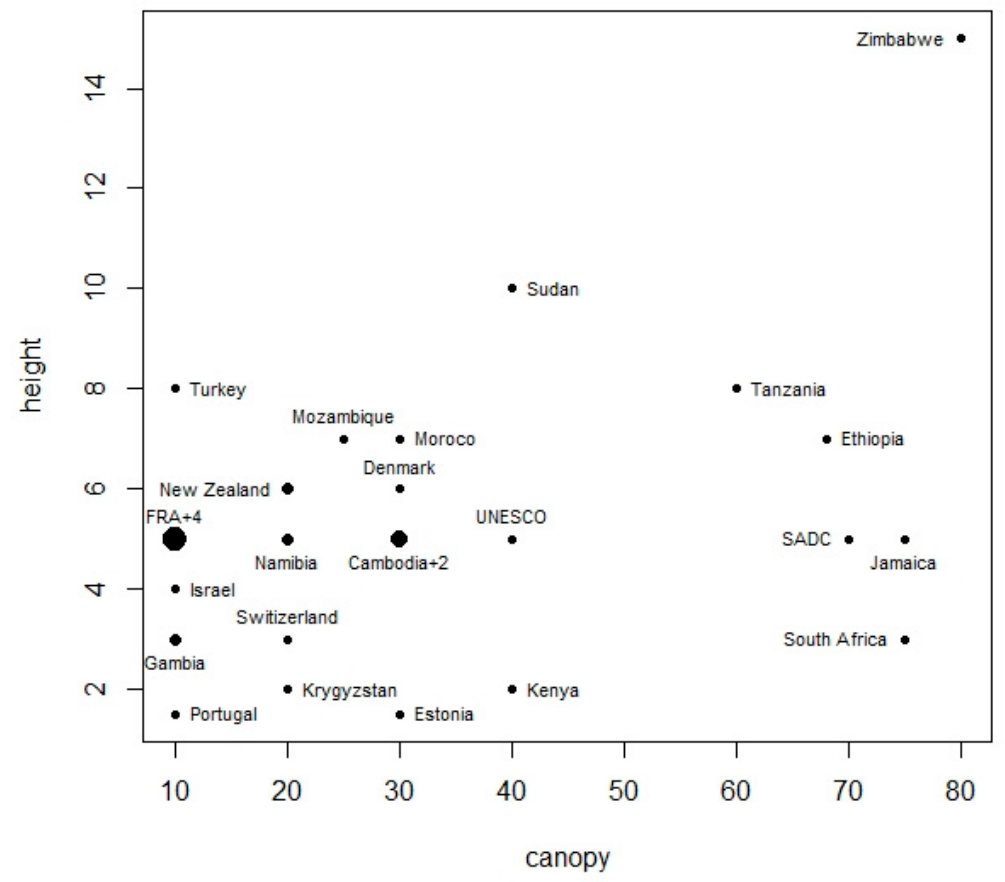
Figure 1. Countries that use canopy cover and tree height to define “forest” (values from Reference